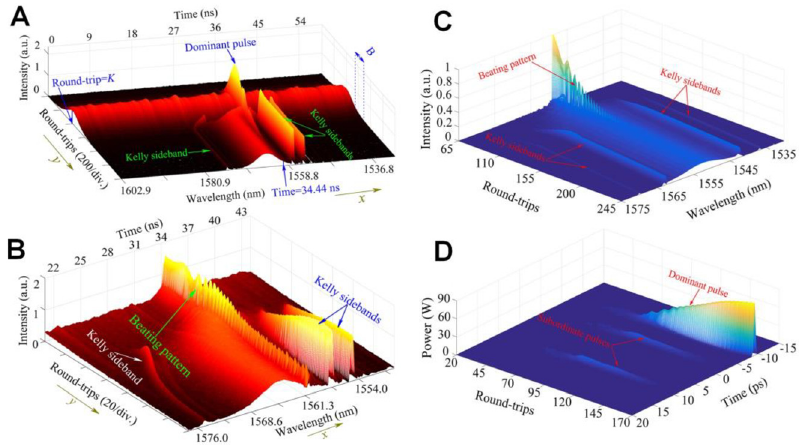
Figure 12: Spectral evolution dynamics of soliton in the QS-ML transition stage. (A, B) Real-time observation results by TS-DFT technique. (C, D) Numerical simulation re- sults with beating dynamics. Liu et al. [73].